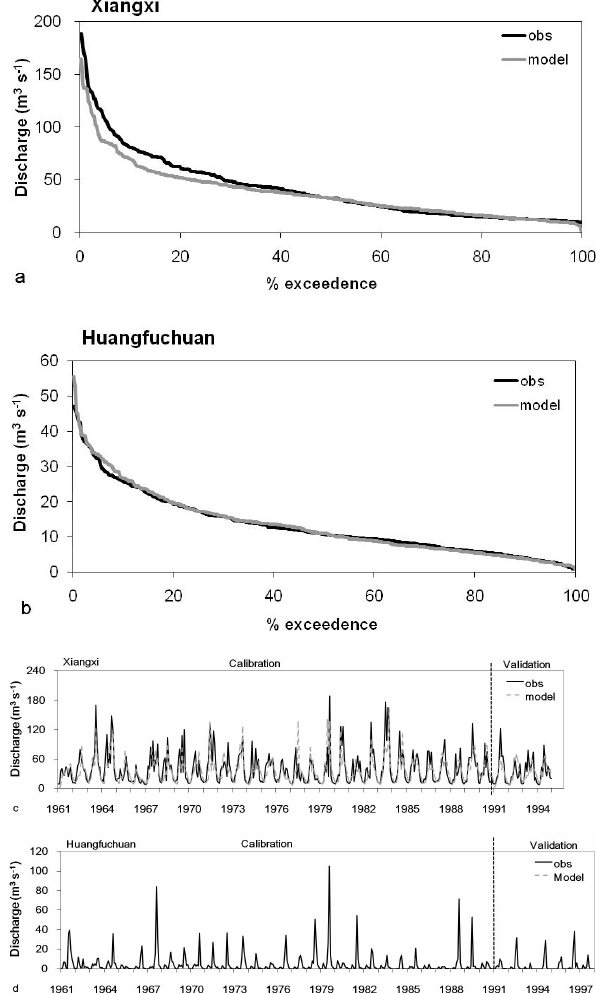
Fig.2. Observed and simulated river discharge in River Xiangxi(1961-1994, a: flow duration curve; c: monthly discharge) and River Huangfuchuan (1961-1997, b: flow duration curve, d: monthly discharge). Fig. 2. Observed and simulated river discharge in River Xiangxi – 1961–1994, (a) flow duration curve; (c) monthly discharge – and River Huangfuchuan for 1961–1997, (b) flow duration curve, (d) monthly